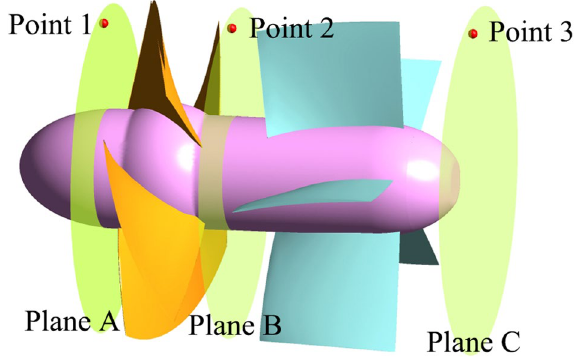
Figure 11. Pressure pulsation monitoring